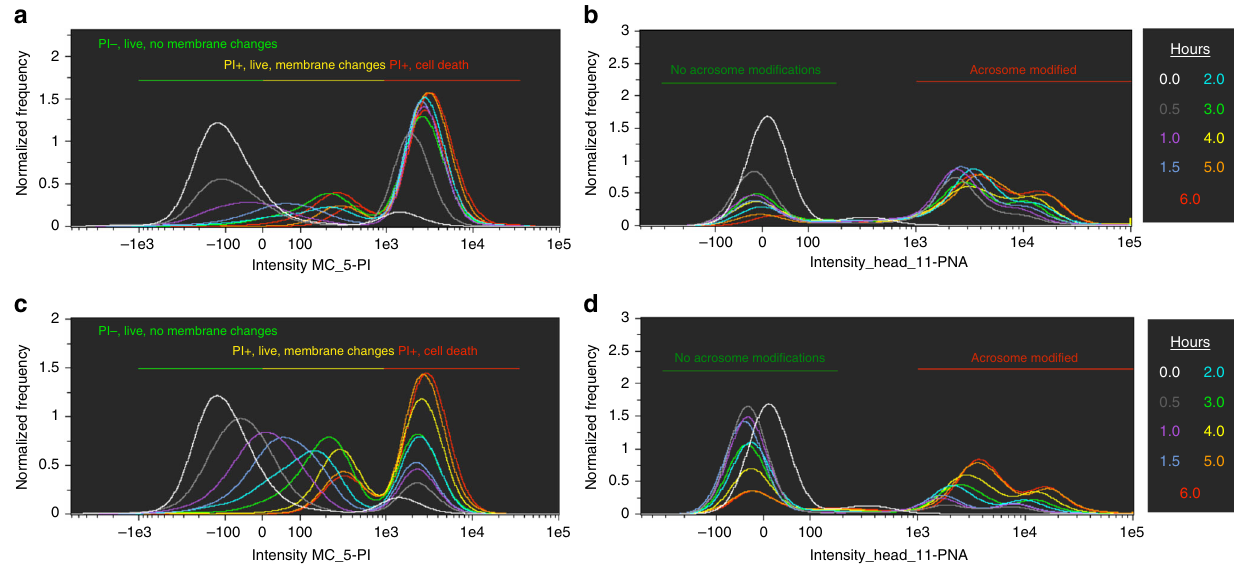
Fig. 2 Zinc signature time course with high vs. low bicarbonate IVC. Time-lapse recordings of zinc signature during IVC in high, 15 mM sodium bicarbonate media : ( a ) plasma membrane changes as identi fi ed by PI status, distinguishing between IVC-induced PI + subpopulations (PI + live with plasma membrane changes vs. PI + cell death). b Acrosomal modi fi cations. Time course of zinc signature modi fi cation in low, 2 mM sodium bicarbonate IVC media : ( c ) plasma membrane changes, and d acrosomal modi fi cations (corresponding histogram color code for time points in fi gure